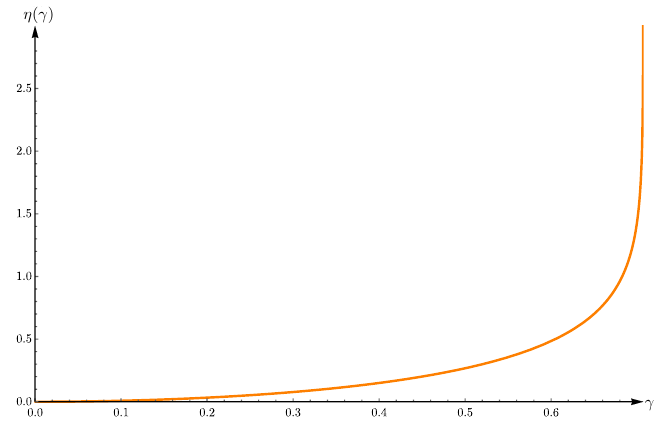
Figure 5 . Plot of η ( γ ) as defined in eq. (3.110), which is the coefficient of the log divergences due to the defect in the volume